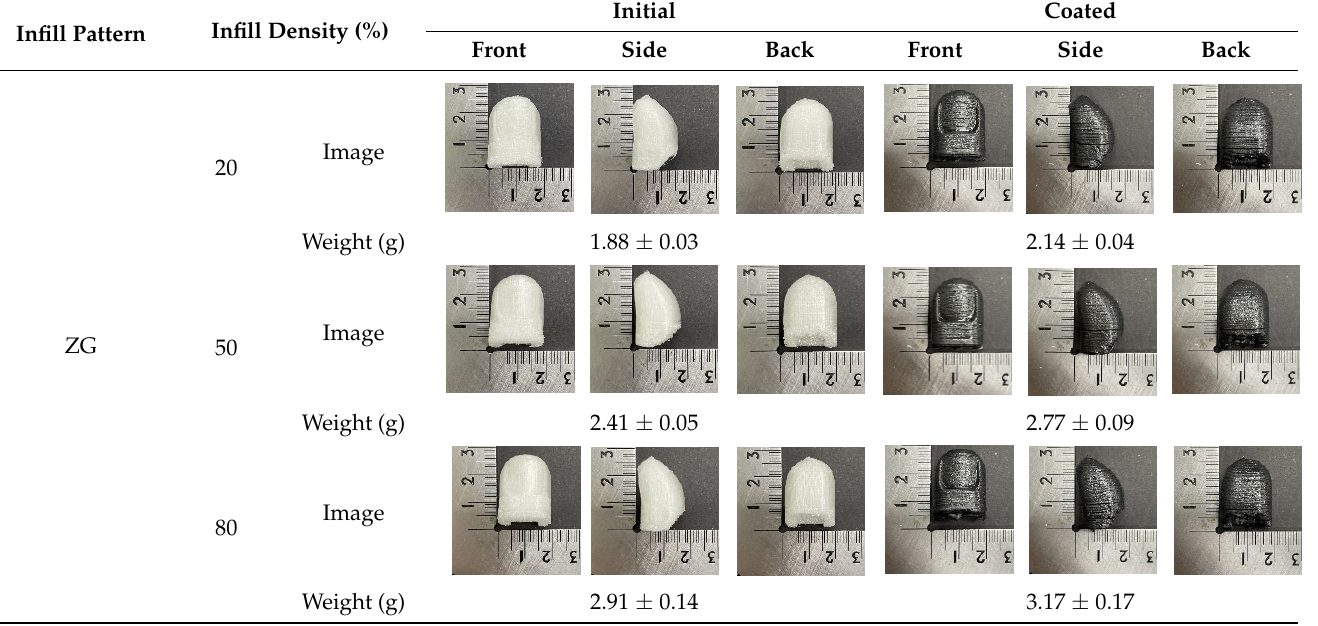
Table 2. Sample images of 3DP fingertips and coated 3DP index fingertips under various infill patterns and densities.